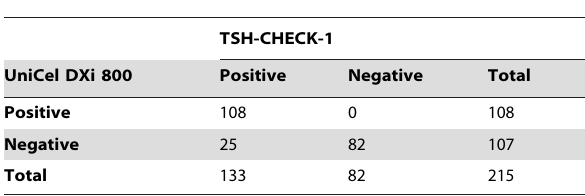
Table 1. Accuracy of TSH-CHECK-1 test compared against reference standard with . 10 m IU/mL as cut-off level for a positive results.